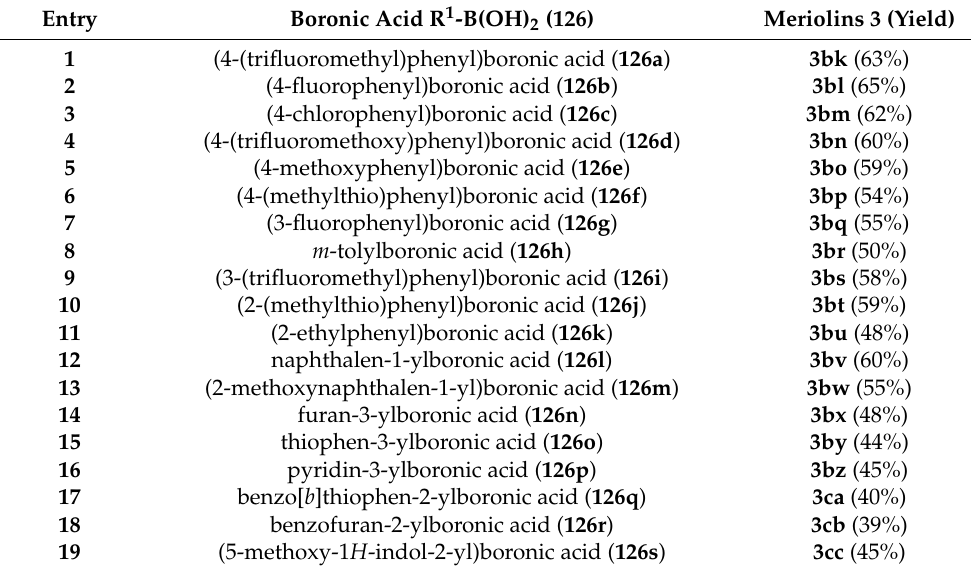
Table 2. Boronic acids 126 used for the functionalization in C-5 position and the corresponding yields of meriolins 3bk - cc .